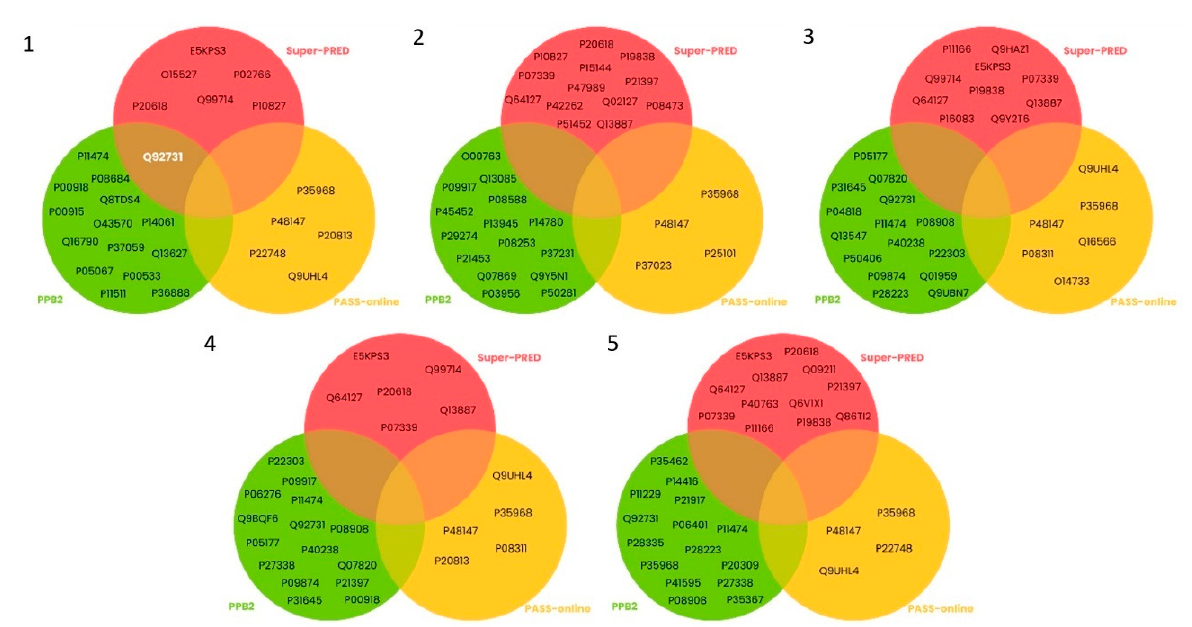
Inorganics 2023 , 10 , x FOR PEER REVIEW Figure 5. Venn diagrams with target prediction comparisons obtained from the three servers. Num- bers on each triad indicate the corresponding BCC in Figure 1.